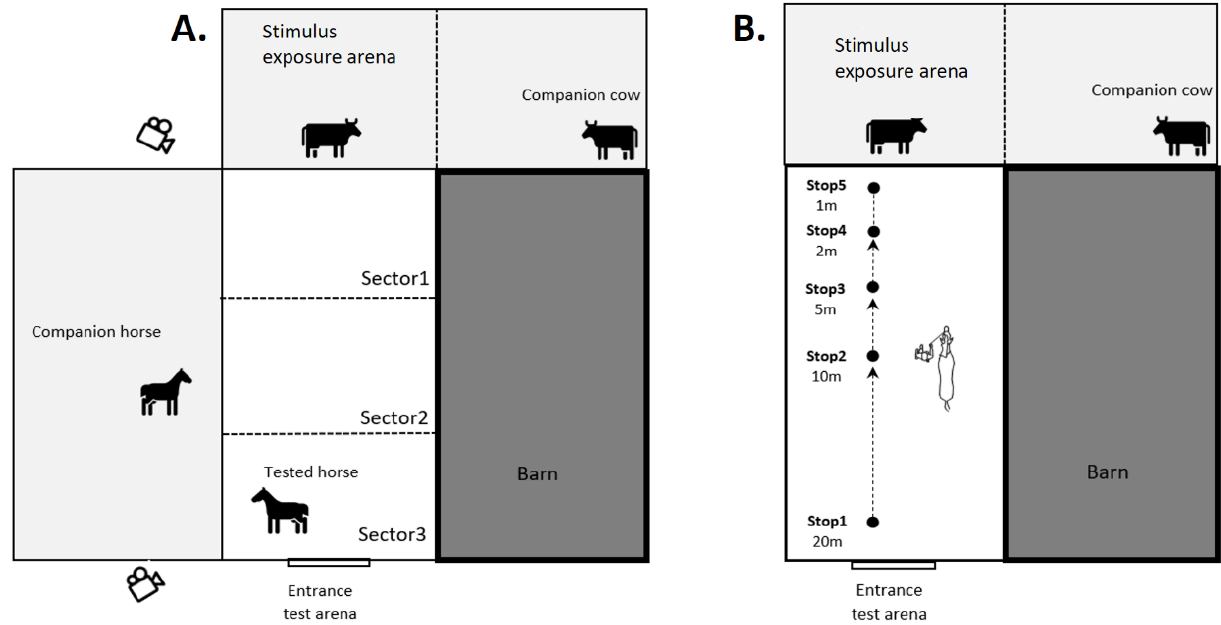
Figure 2. Schematic representation of ( A ). Arena test and ( B ). Hand-leading F igure 2. Schematic representation of ( A ). Arena test and ( B ). Hand-leading test.